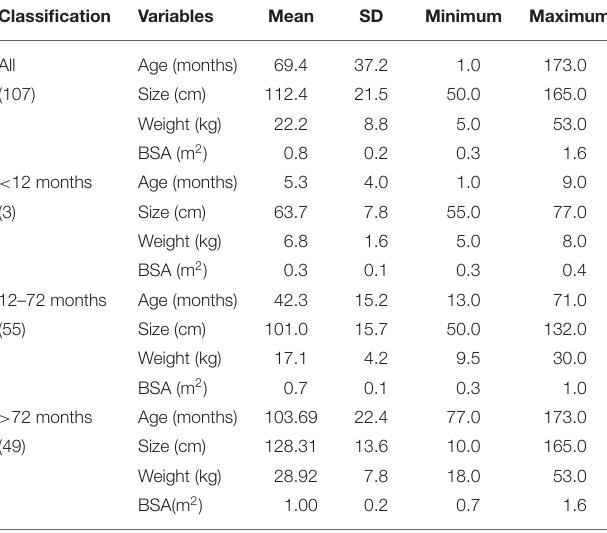
TABLE 1 | The characteristics of all patients (61.7% boys and 38.3% girls), and these data were classified by months. Classification